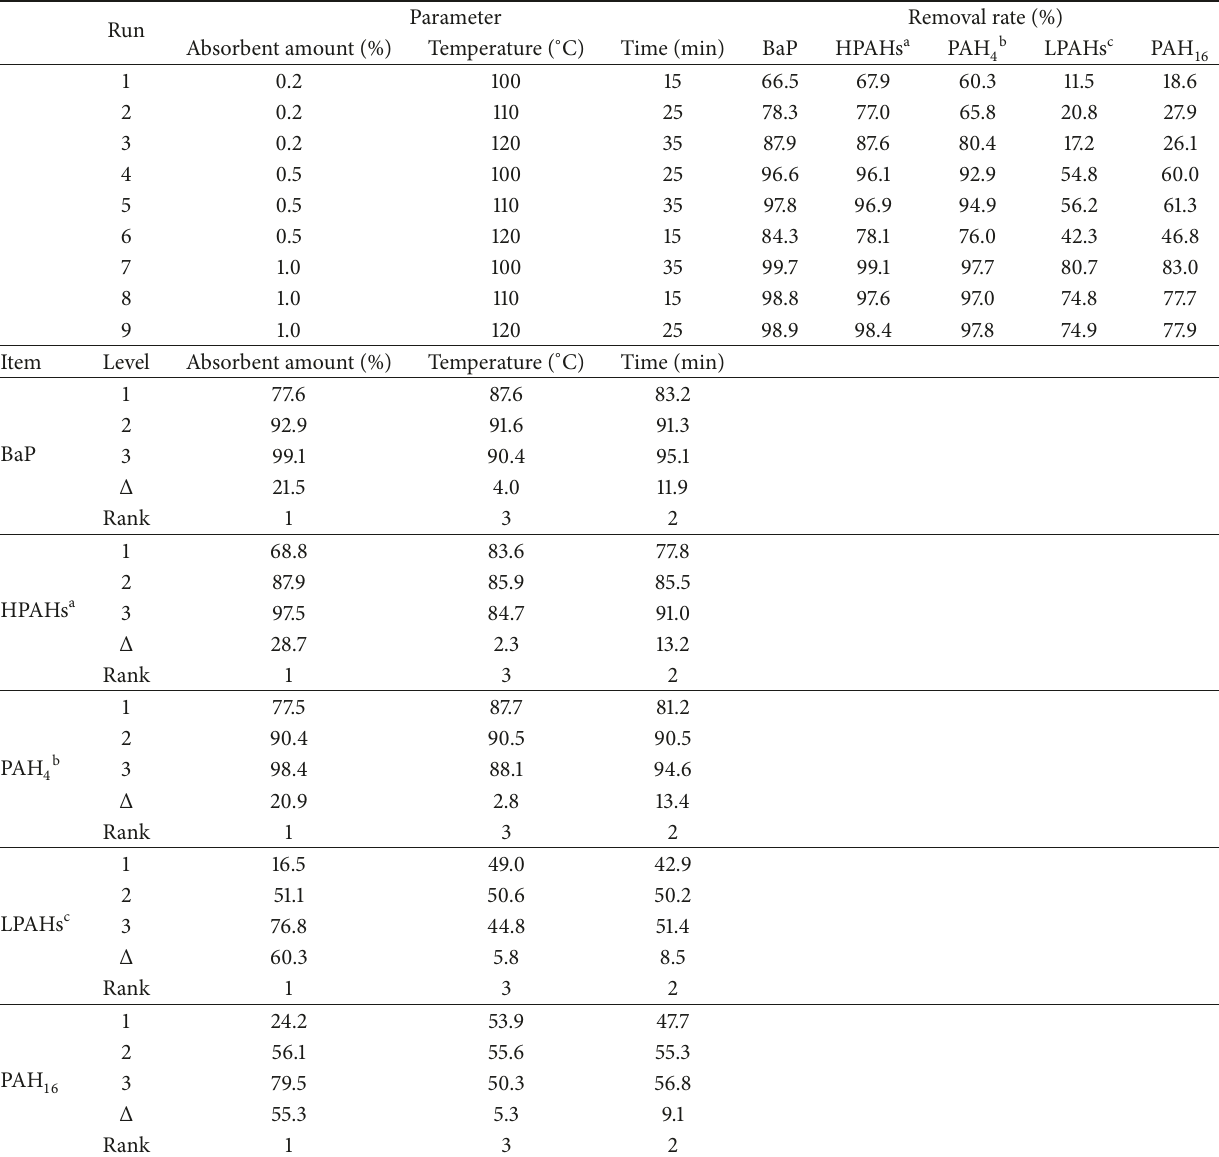
Table 3: Results of decoloration on